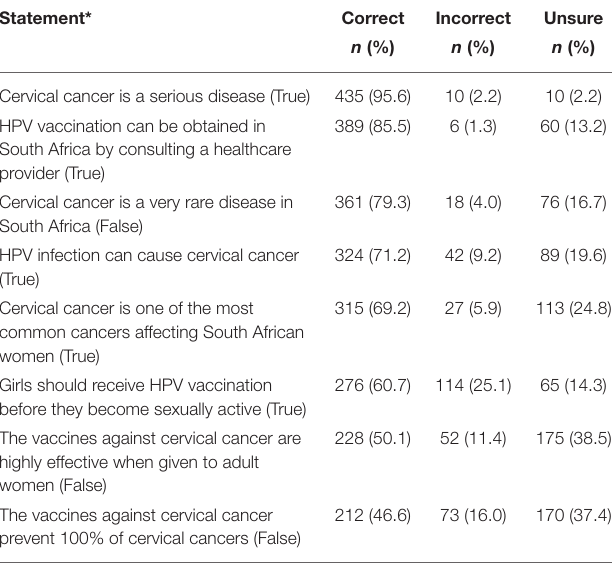
TABLE 4 | Caregivers’ knowledge about HPV, HPV vaccine, and cervical cancer ( n =